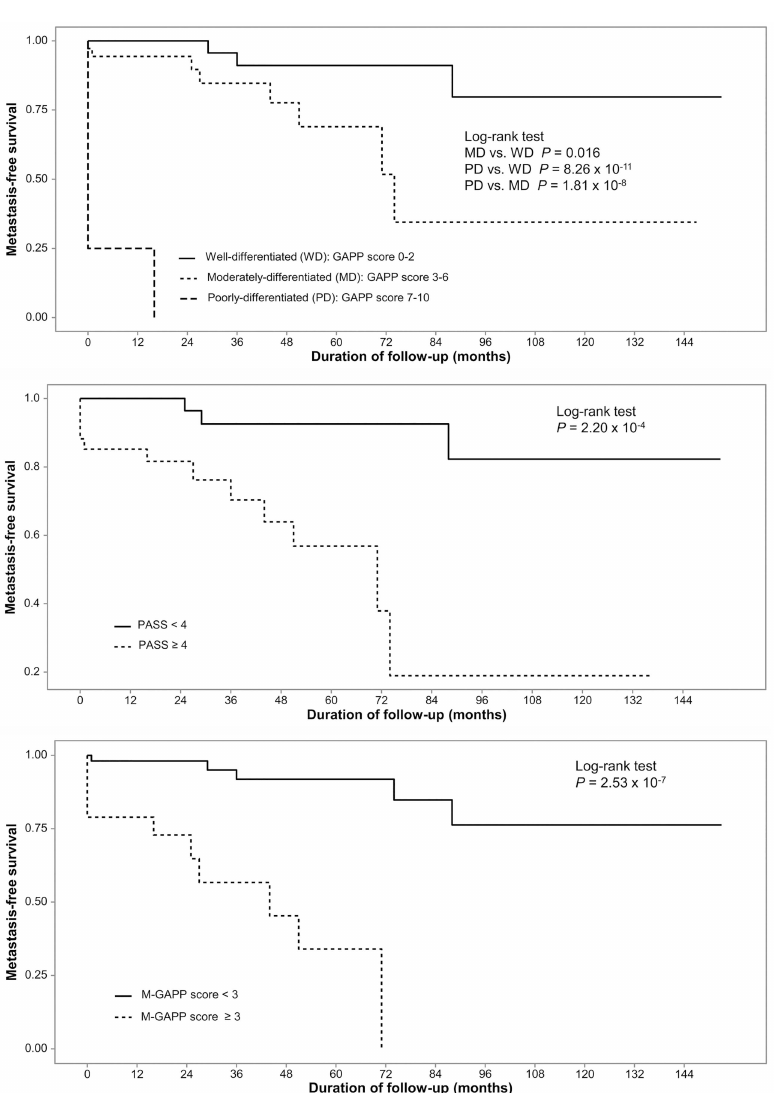
Fig 2. Metastasis-free survival analysesaccording to the Grading systemfor Adrenal Pheochromocytoma and Paraganglioma (GAPP) score, Pheochromocytoma of the Adrenal Scaled Score (PASS), and modified GAPP (M-GAPP) score at the initial